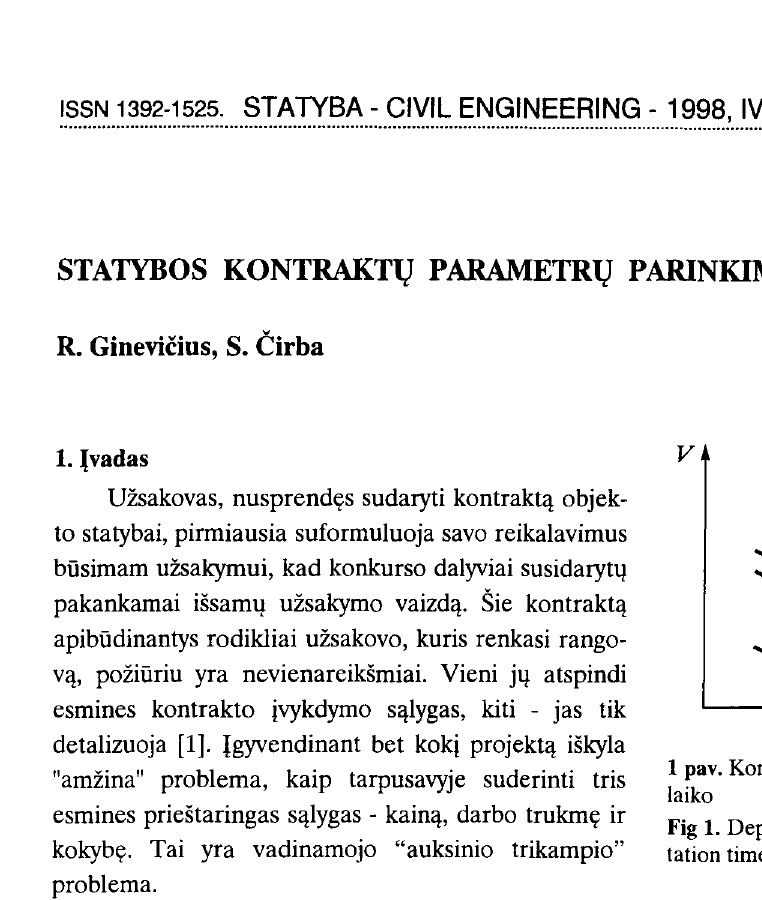
Fig 1. Dependency of contract parameters on its implemen tation